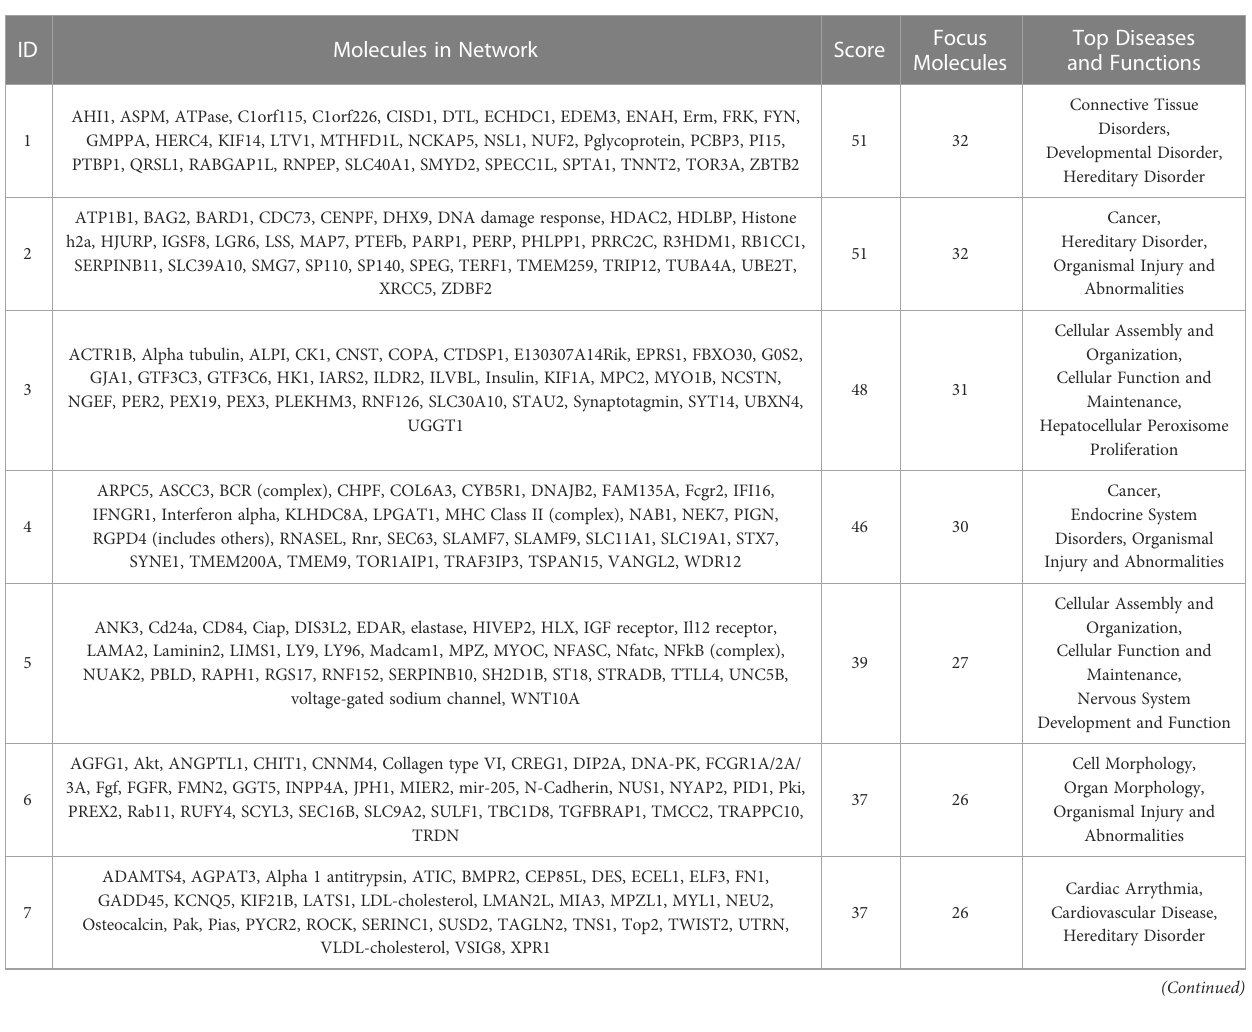
TABLE 2 A list of molecular networks of DEGs in Dep versus